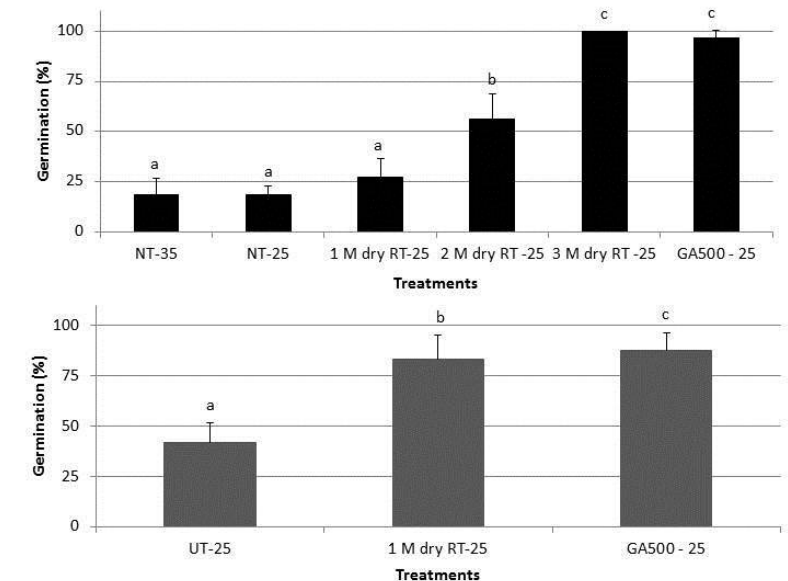
Figure 2: Germination of A. paniculata var. paniculata (A) and B. prionitis (B) seeds after 0, 1, 2 and 3 months of dry storage at ambient laboratory temperature and incubated on filter papers moistened with distilled water or 500 ppm GA ° C temperature in light/dark (12 h/12 h) conditions. Error bars are ± SD. Different lowercase letters indicate significant differences between treatments within the same species ( A. paniculata [F = 10.2, P = 0.005, n = 4]; B. prionitis [F = 43.8, P < 0.001, n = 4]). NT - 25, non-treated seeds incubated at 25 ° C; NT - 35, non-treated seeds incubated at 35 ° C; 1 M dry RT - 25, seeds incubated at 25 ° C after 1-month dry storage at ambient room temperature; 2 M dry RT - 25, seeds incubated at 25 ° C after 2-month dry storage at ambient room temperature; 3 M dry RT - 25, seeds incubated at 25 ° C after 3-month dry storage at ambient room temperature; GA 500 – 25, seeds incubated at 25 ° C on tissue papers moistened with 500 ppm GA